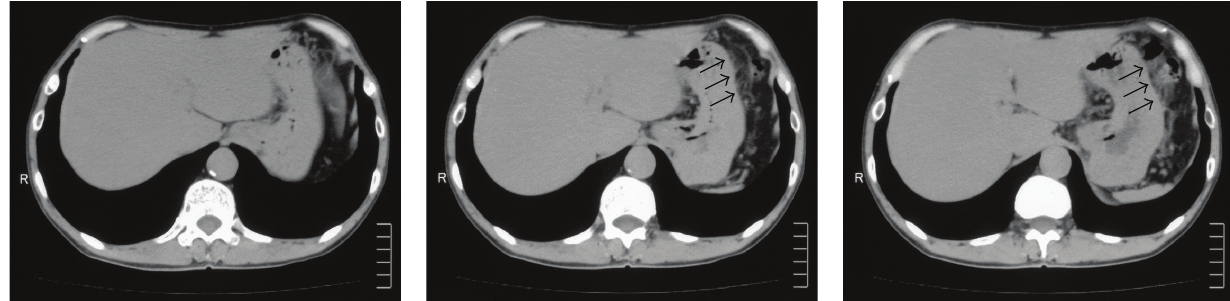
Figure 2: Abdominal computed tomography before treatment. Computed tomography showed fluffing surrounding the gastric body (arrows).